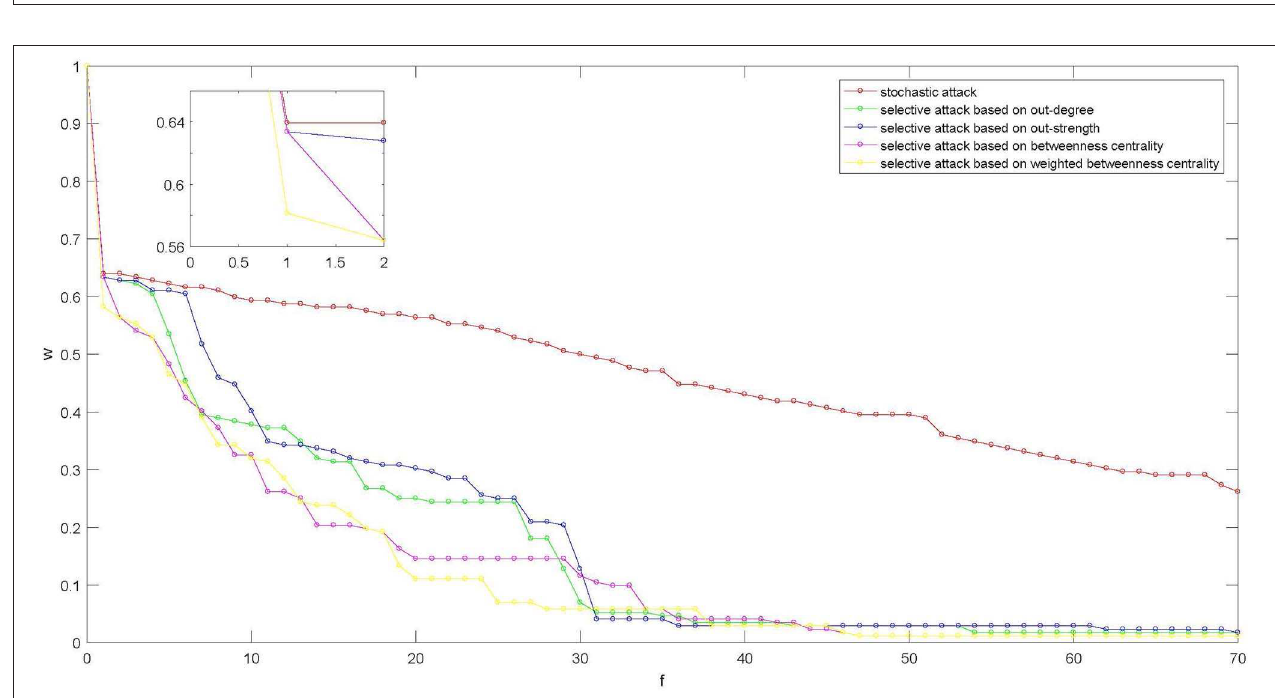
FIGURE 6 | Remittance matrix before and after permutation based on community structure.